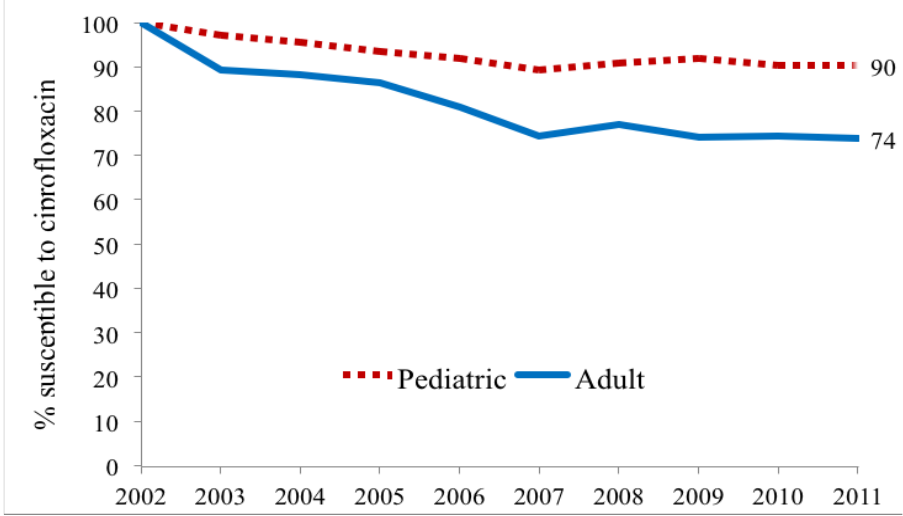
Figure 1. Adult and pediatric ciprofloxacin susceptibility trends for E. coli positive urinary cultures.